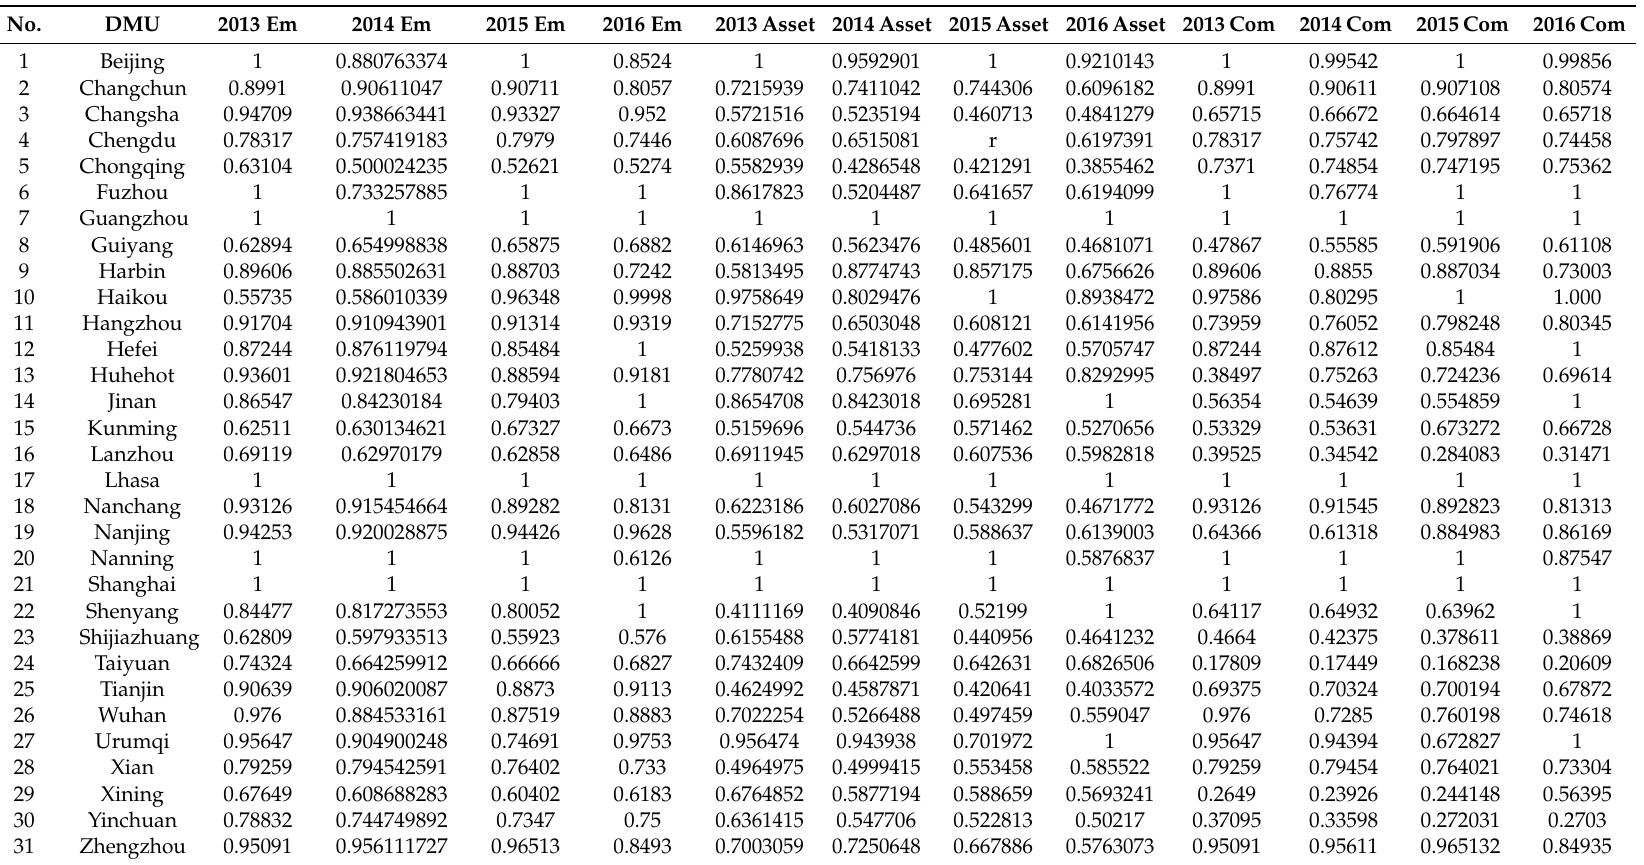
Table 4. Employment, fixed assets investment, and energy consumption efficiency